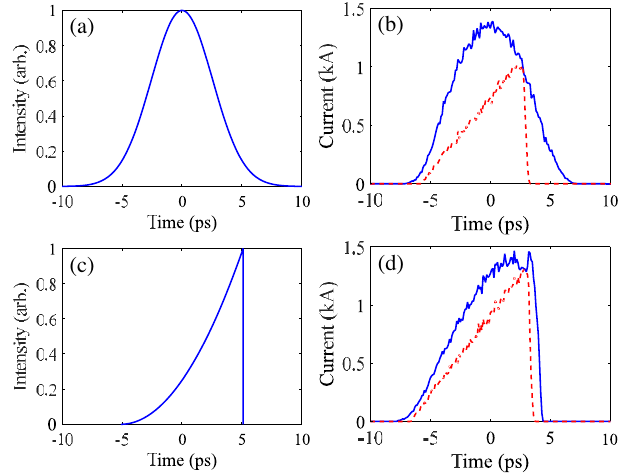
FIG. 10. (a) Gaussian laser profile. (b) Electron beam profiles started from Gaussian laser profile. (c) Shaped laser profile. (d) Electron beam profiles started from the shaped laser profile. Blue and red curves correspond to electron profiles before and after the shaping, respectively. The beam images before and after the mask are given in Appendix